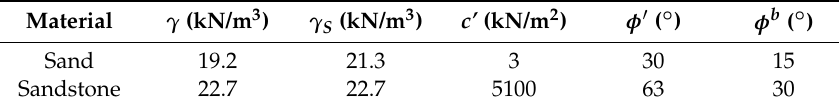
Table 2. Mechanical properties of slope material.